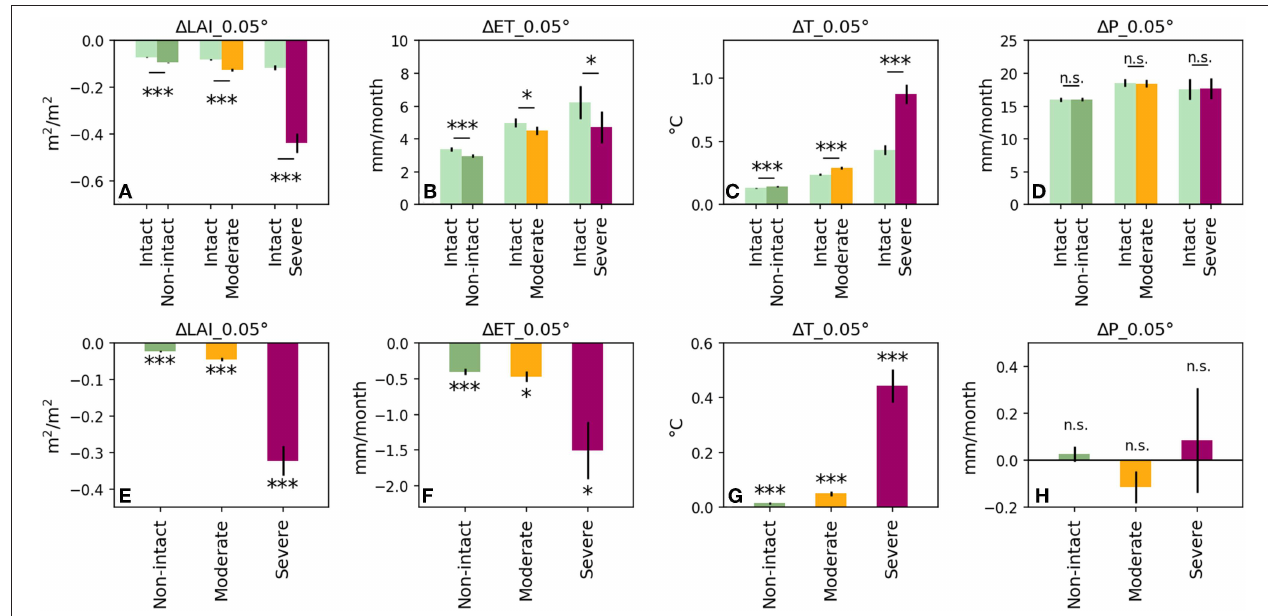
FIGURE 2 | (A–D) Absolute changes in annual mean 0.05 ◦ remotely-sensed leaf area index (A) , evapotranspiration (B) , daytime land surface temperature (C) , and precipitation (D) , averaged over pixels in each disturbance category and the corresponding neighboring intact forest (see Figure 1B ), for the period 2001–2013.